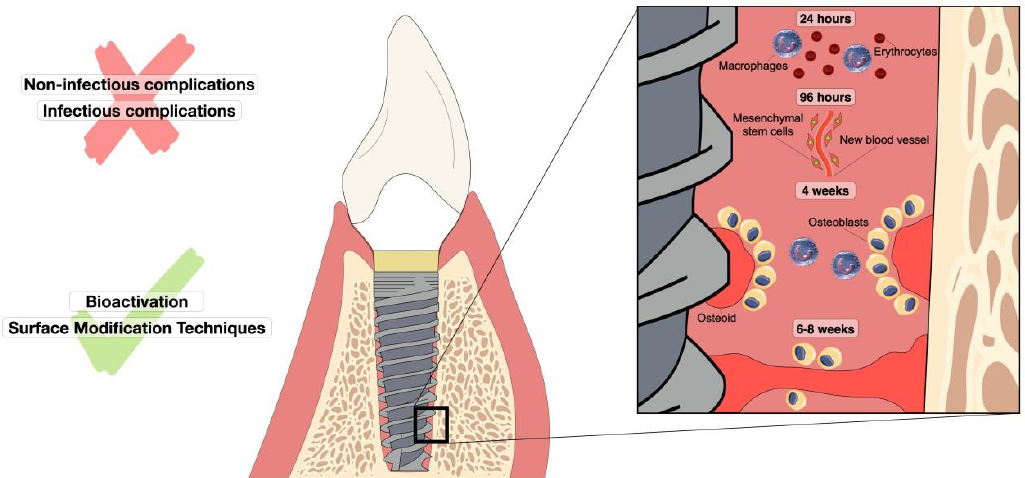
Figure 1. Representation of oral osseointegration events over time in a dental implant. The figure shows the sequence of cellular-level responses that occur after implant insertion for 24 h to approximately 8 weeks. Non-infectious and infectious complications are reported as factors that hinder osseointegration. Factors that improve this process are bioactivation and surface modification